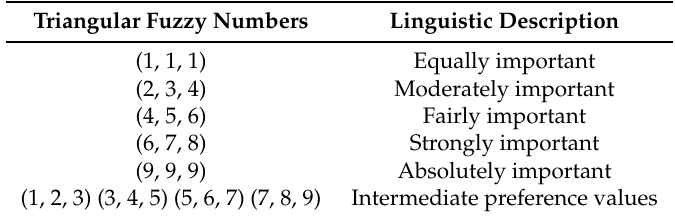
Table 2. Scale values of triangular fuzzy numbers.